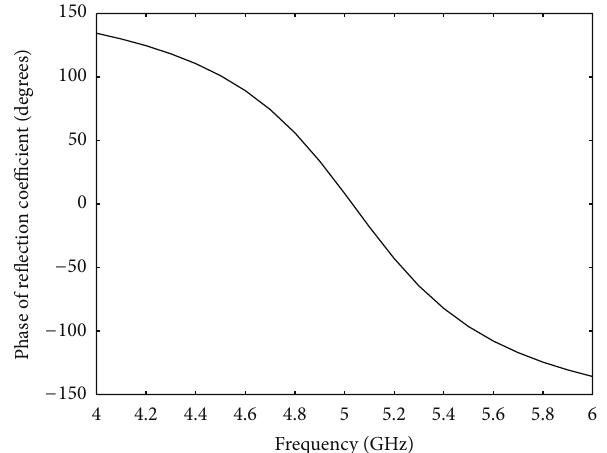
Figure 9: Reflection coefficient for the 5GHz EBG.